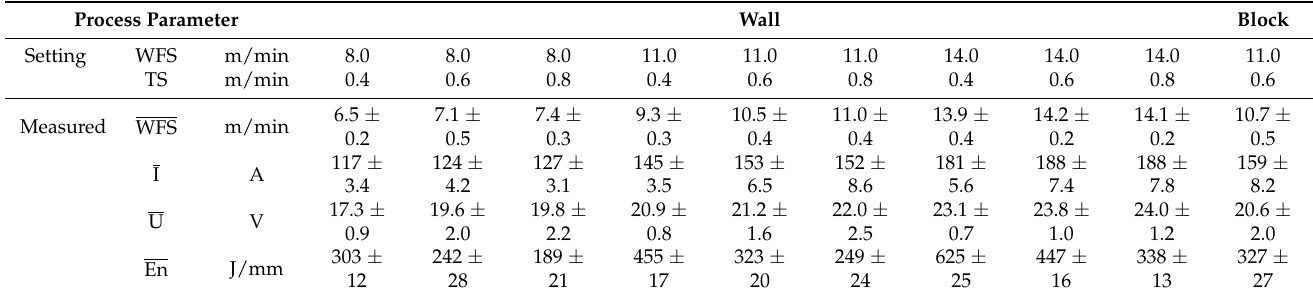
Table 3. Process parameters of different WAAM parts with HY282 ( Φ 0.04 (cid:48)(cid:48) ) and shielding